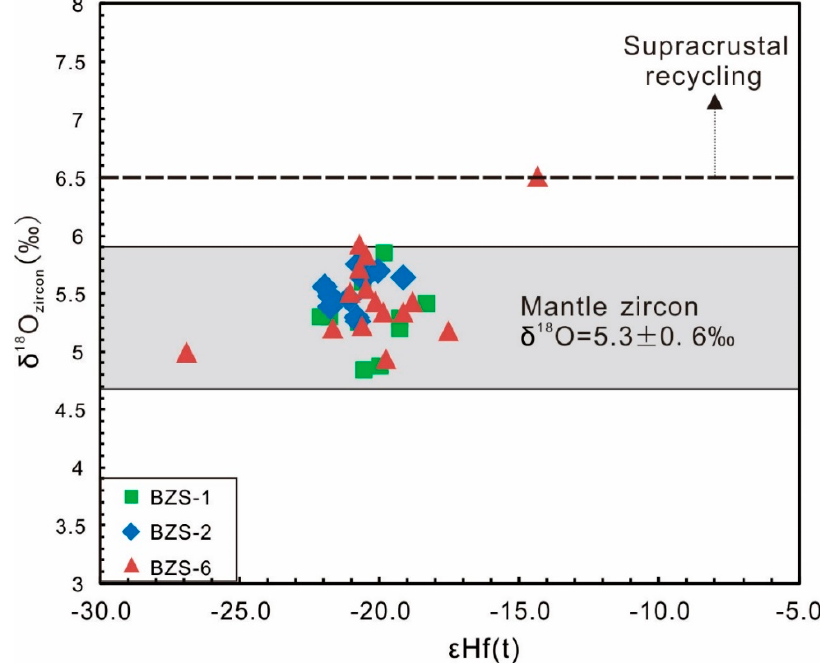
Figure 8. Combined zircon Hf-O isotope diagram from the Banzhusi granite porphyry. The range of δ 18 O values of mantle zircons is from [74–76].